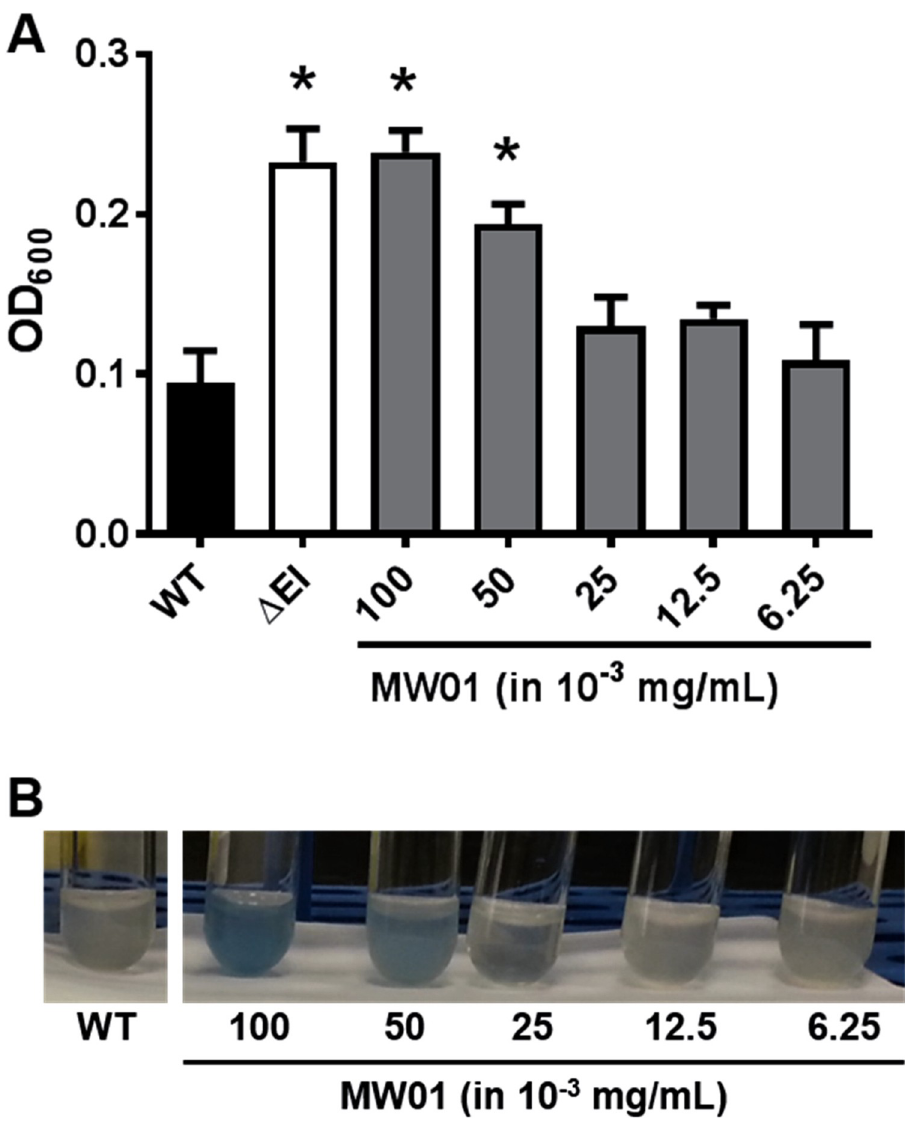
Fig 6. Impact of MW01 concentration on V . cholerae biofilm formation. (A) Wild type (WT) V . cholerae cultures were used to inoculate borosilicate tubes filled with 1 μ L of working MW01 solutions, at concentrations ranging from 0.00625–0.1 mg/mL, and 300 μ l of MM Pyr broth. The resulting biofilm cells were harvested after 20 hours of incubation at 27˚C, and their optical densities were determined at 600 nm (OD 600 ). A PTS mutant ( Δ EI) served as positive control for biofilm growth. Stars indicate measurements that were statistically significantly different from WT biofilm formation in MM Pyr alone. (B) WT V . cholerae biofilms forming at the air-liquid interface in borosilicate culture tubes while growth medium changes coloration in presence of